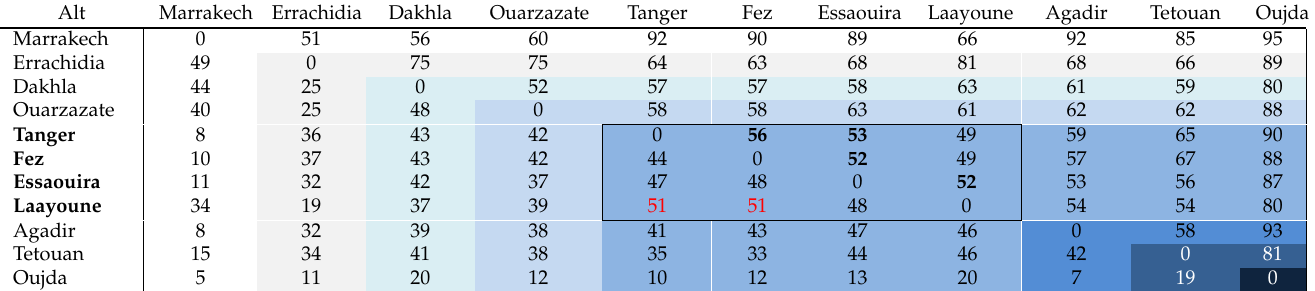
Here, the ‘ ≈ ’ mark denotes equal ranking, indicating that the four alternatives share ranks 5–8. In this case, the shared ranks are due to four alternatives winning each other in a non-transitive (cyclic) manner. There are two cycles, as illustrated in Figure 4: (Tanger (cid:31)